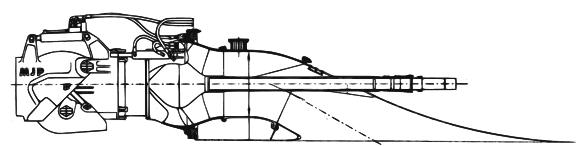
Figure 3: Typical waterjet with mixed-flow pump.